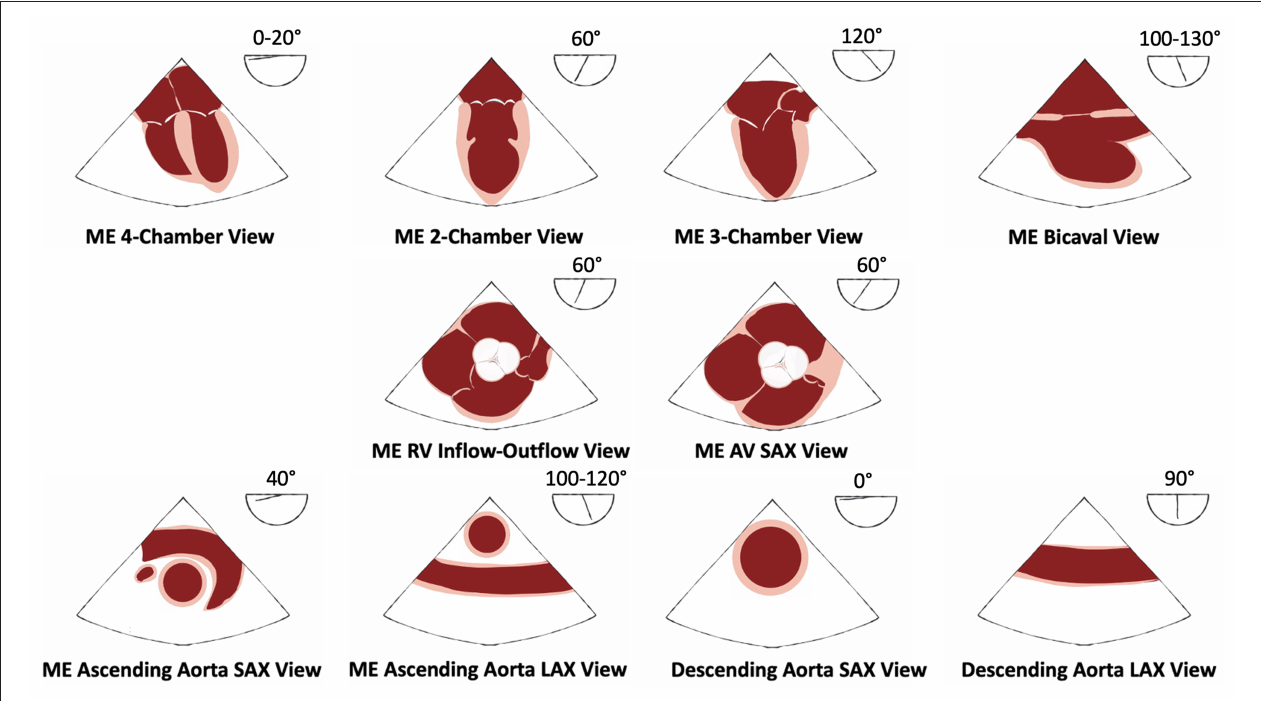
FIGURE 2 | Ten basic TEE views for the practical test with anatomic structures assessed. AV, aortic valve; LAX, long axis; ME, midesophageal; RV, right ventricle; SAX, short axis; TEE, transesophageal